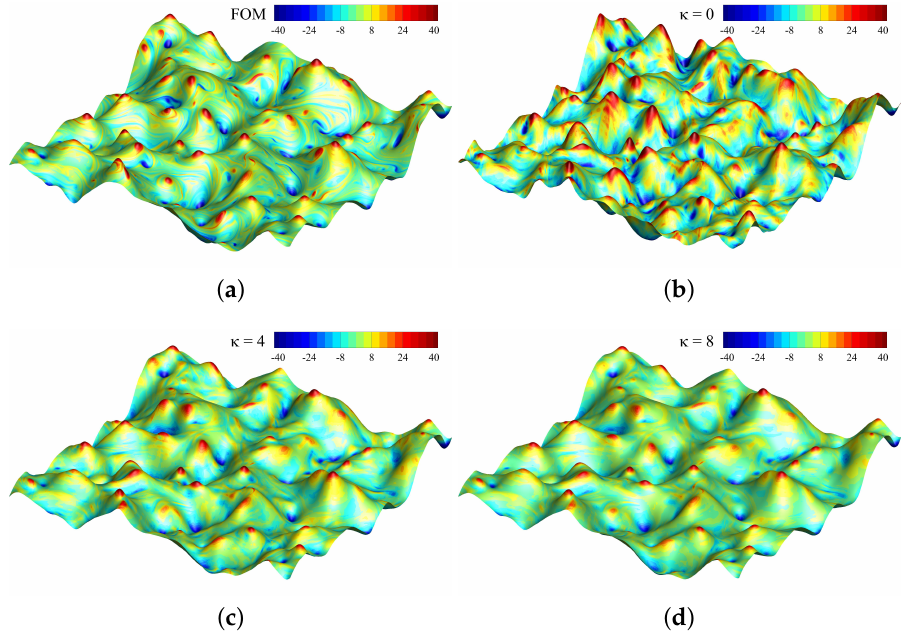
Figure 10. Predicted results in the presence of closure modeling at time t = 4 showing vorticity contours in color with the level of streamfunction as height. ( a ) full order model (FOM), ( b ) ROM with κ = 0, ( c ) ROM with κ = 4, and ( d ) ROM with κ = 8. For ( b – d ): R = 16 and P = 1.